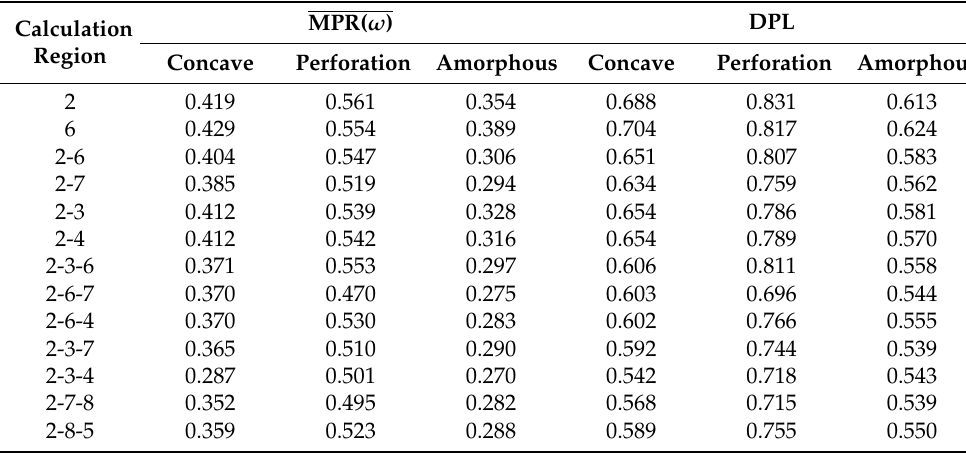
Table 2. MPR ( ω ) and DPL in the same region with different structures.